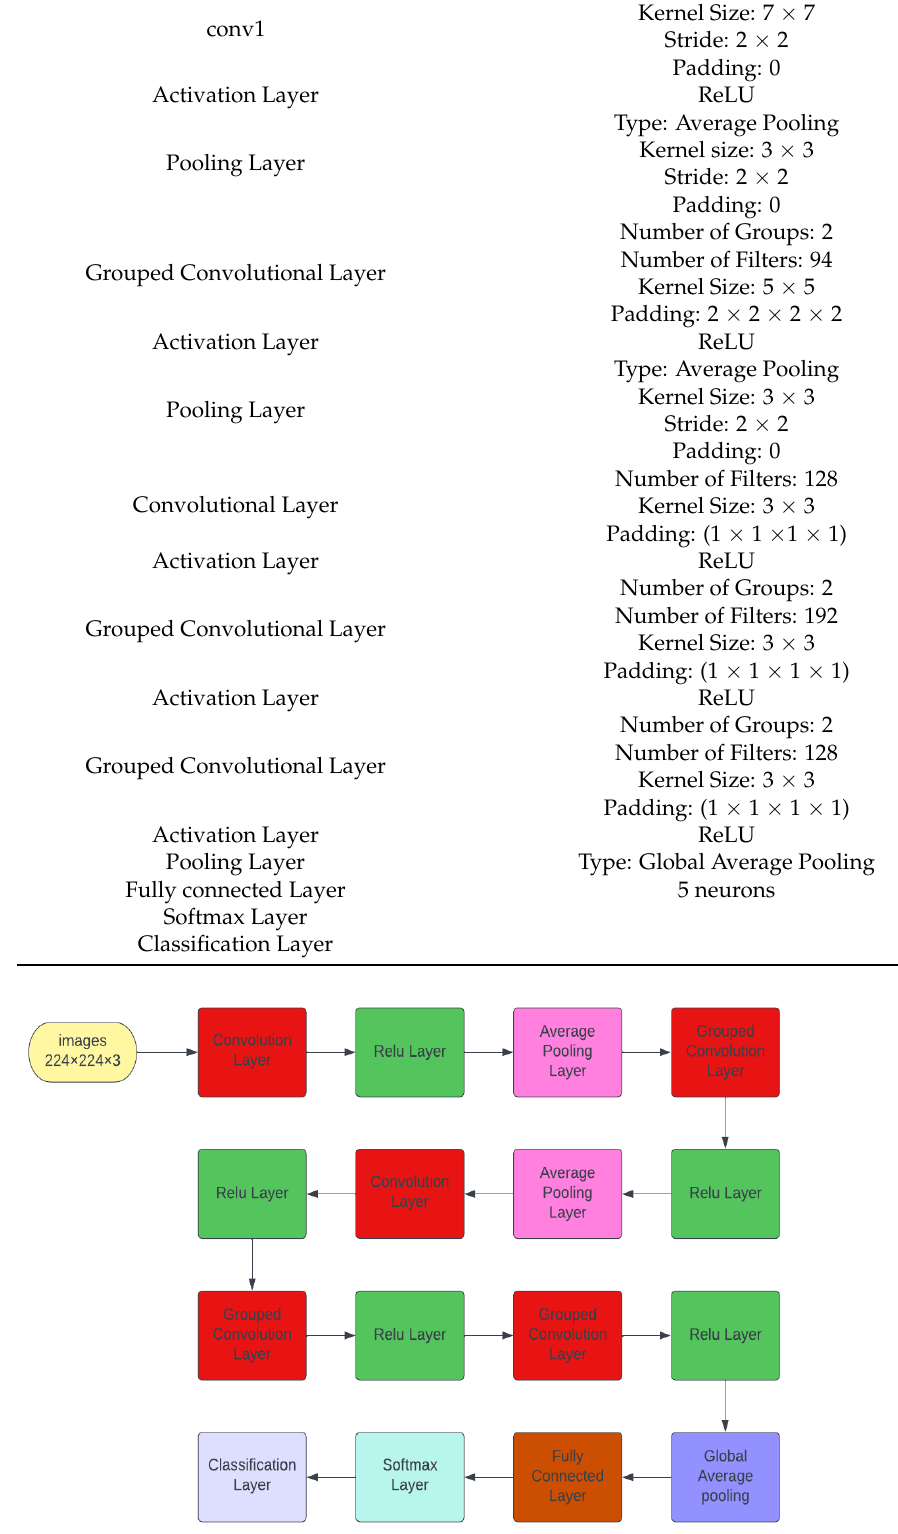
Figure 4. Cervical Net